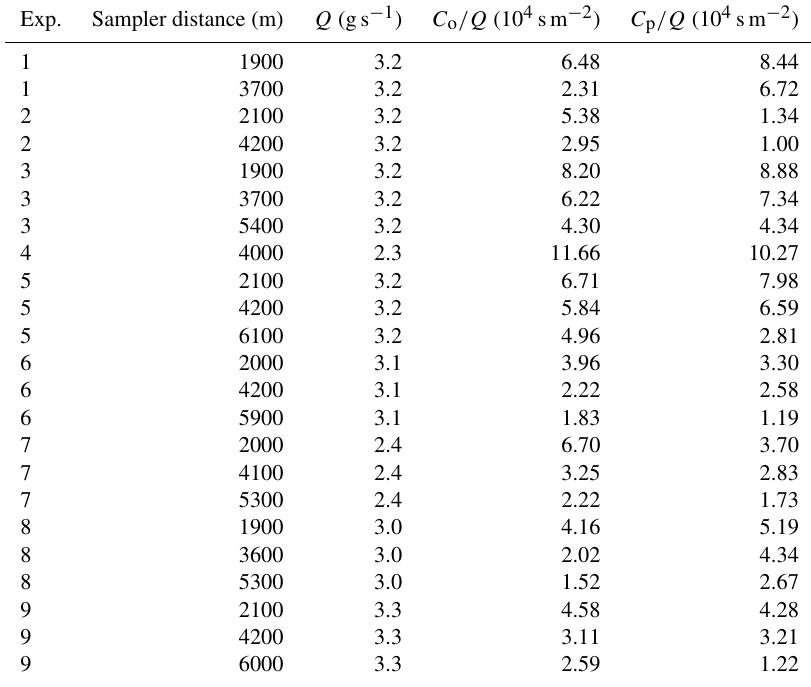
Table A2. Observed C o and predicted C p crosswind-integrated concentrations normalized by the emission rate ( Q ) for Copenhagen experi- ments.